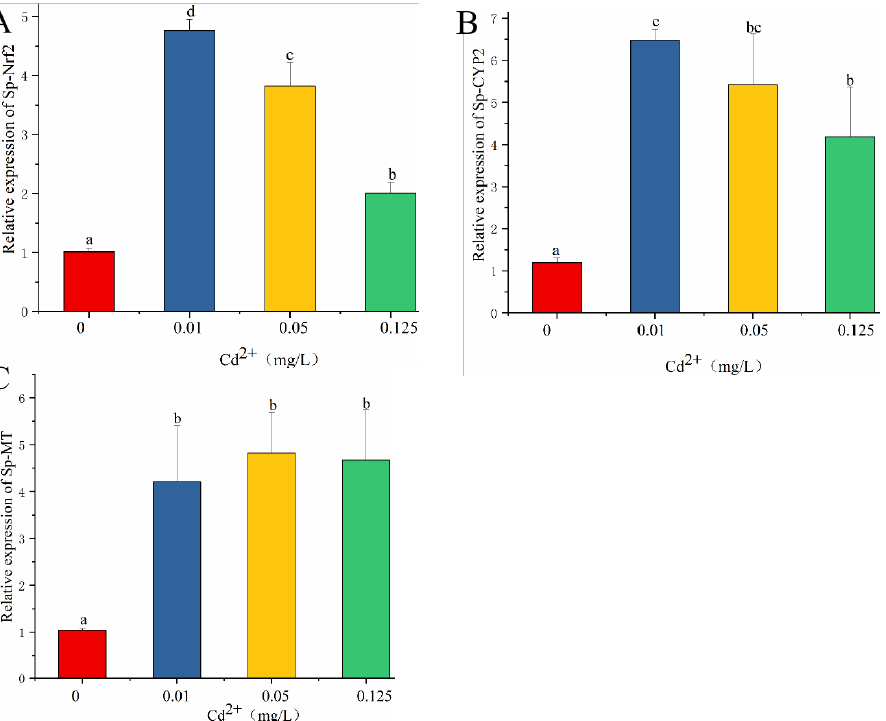
Figure 3. Effects of cadmium exposure on the expression levels of Nrf2 ( A ), CYP2 ( B ), and MT ( C ). Values are expressed as the mean ± SD. Different letters reflect significant differences between the control group and the cadmium treatment groups ( p < 0.05).